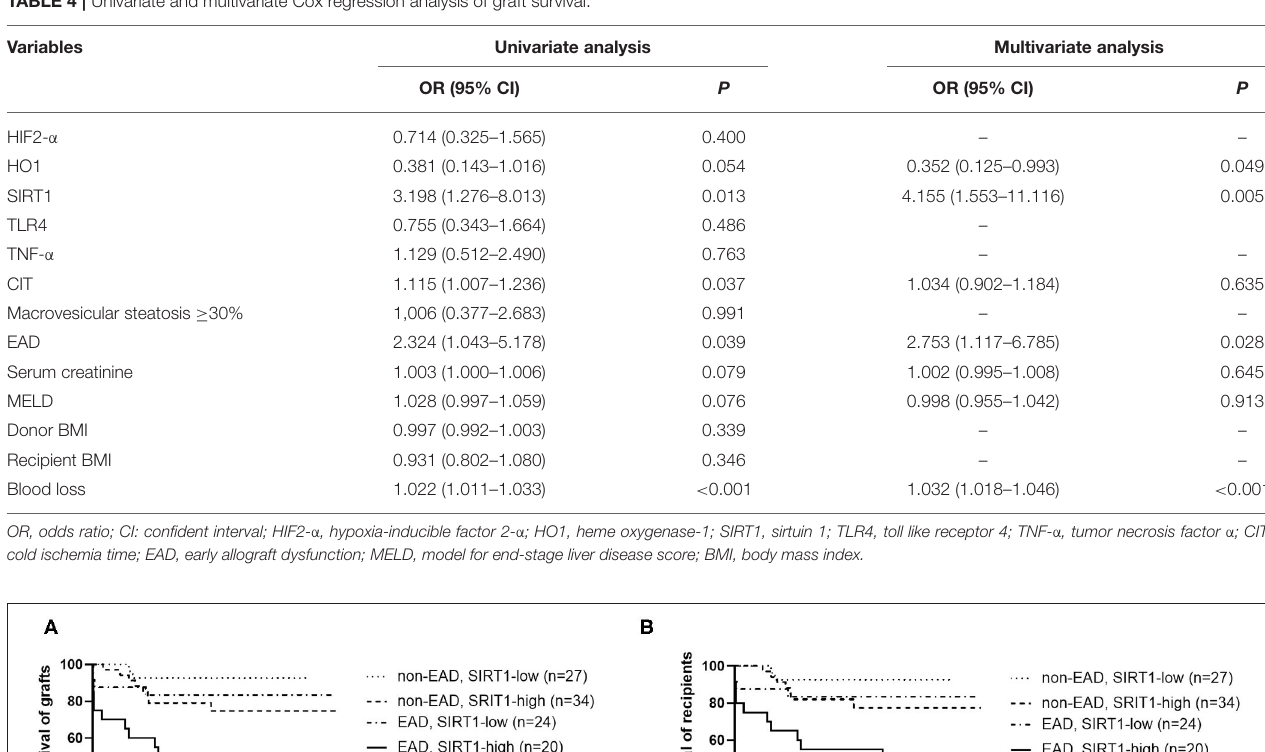
TABLE 4 | Univariate and multivariate Cox regression analysis of graft survival.